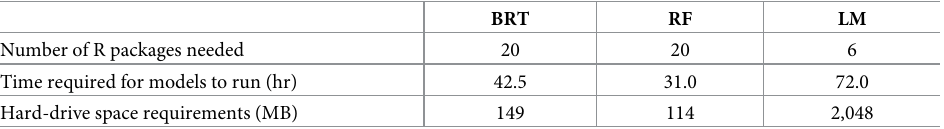
Table 5. Comparison of computational aspects for the Machine Learning (Boosted Regression Trees (BRT), Ran- dom Forest (RF)) and Linear Model (LM) methods investigated. The methods under comparison used log-trans- formed FoI values from the FullPostFoI